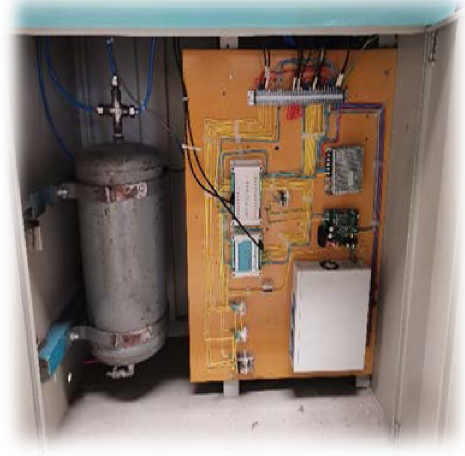
Fig. 5. The interior of the